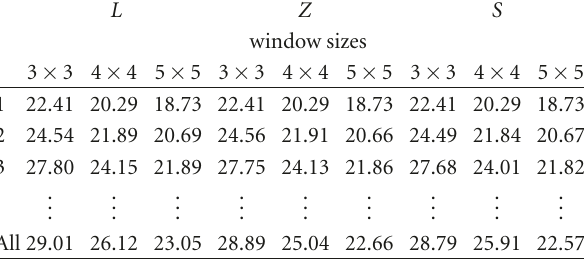
Table 4: Signal to noise ratio (dB) for two-dimensional FMP.